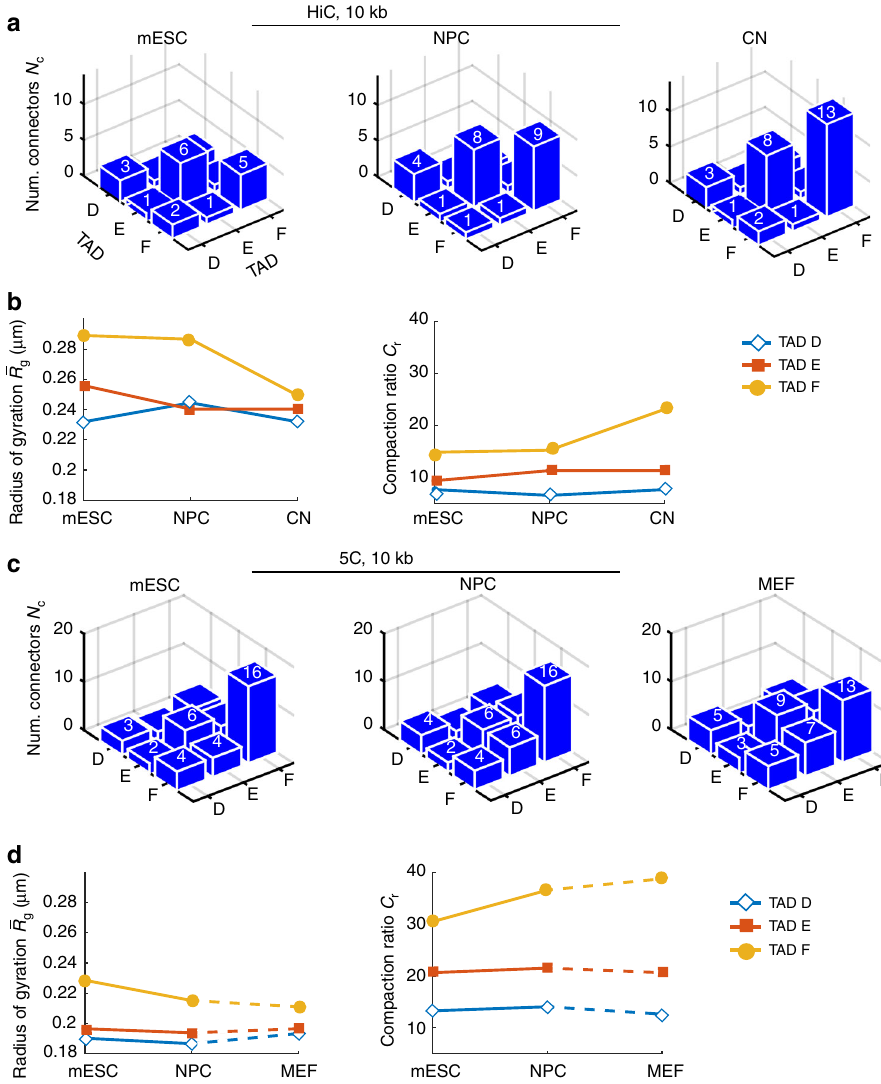
Fig. 3 Comparing TADs reconstruction during cell differentiation between Hi-C and 5C. a Average number of connectors within and between TADs D, E, and F of Hi-C data 34 of the X chromosome binned at 10 kb, obtained by fi tting the empirical EP with Eqs. (3) and (5), where TAD boundaries were obtained in ref. 1 for mouse embryonic stem cells (mESC, left), neuronal progenitor cells (NPC, middle), and cortical neurons (CN, right). The average number of connectors within and between TADs are presented in each blue box. b Mean radius of gyration (left) for TAD D, E, and F, throughout three successive stages of differentiation of the Hi-C data, with b = 0.18 μ m obtained from Supplementary Methods Equation 67, and the compaction ratio (right, Eq. (9)). c Average number of connectors within and between TADs D, E, and F of the 5C data 1 of the X chromosome binned at 10 kb, obtained by fi tting the empirical EP with Eqs. (3) and (5) for mESC (left), NPC (middle), and MEF (right). d Mean radius of gyration (left) for TAD D, E, and F of the 5C data, and the compaction ratio (right, Eq.